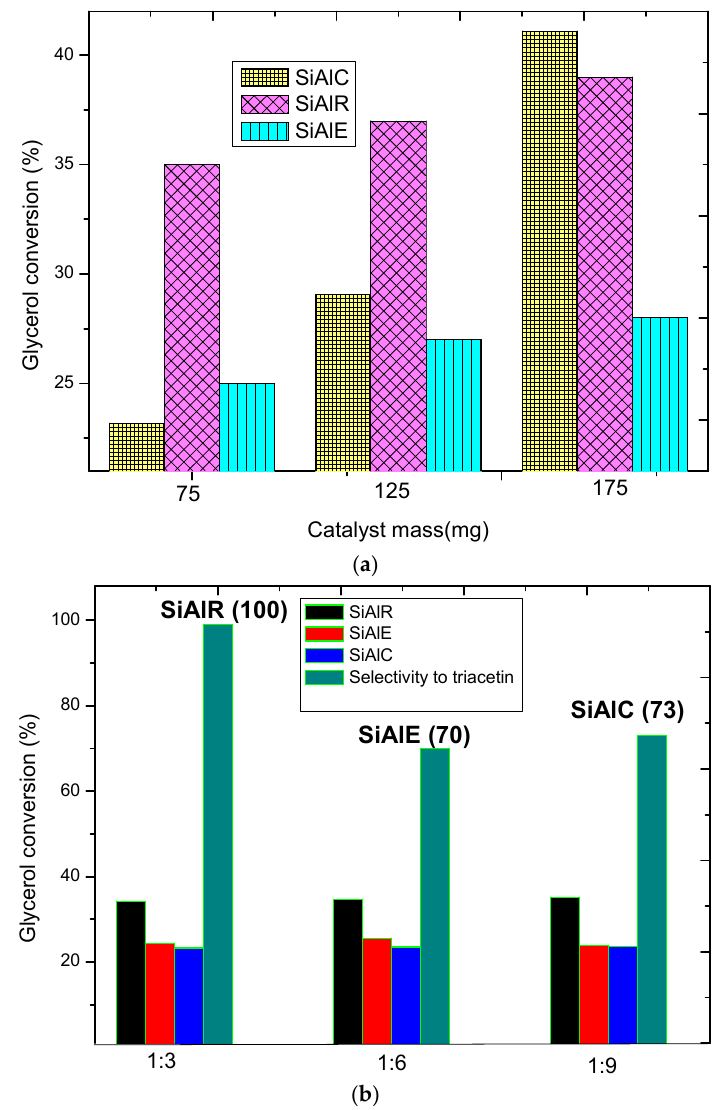
Figure 8. ( a ) Effect of the catalyst mass on the conversion of glycerol and selectivities. Reaction conditions: glycerol to acetic acid molar ratio = 1:3 and T = 80 °C for 20 h; ( b ) Effect of the glycerol to acetic acid molar ratios on the conversion and selectivity to triacetin. Reaction conditions are: catalyst mass of 75 mg at 80 ° C for 20 h. The values in parenthesis are the selectivities to triacetin of the samples.